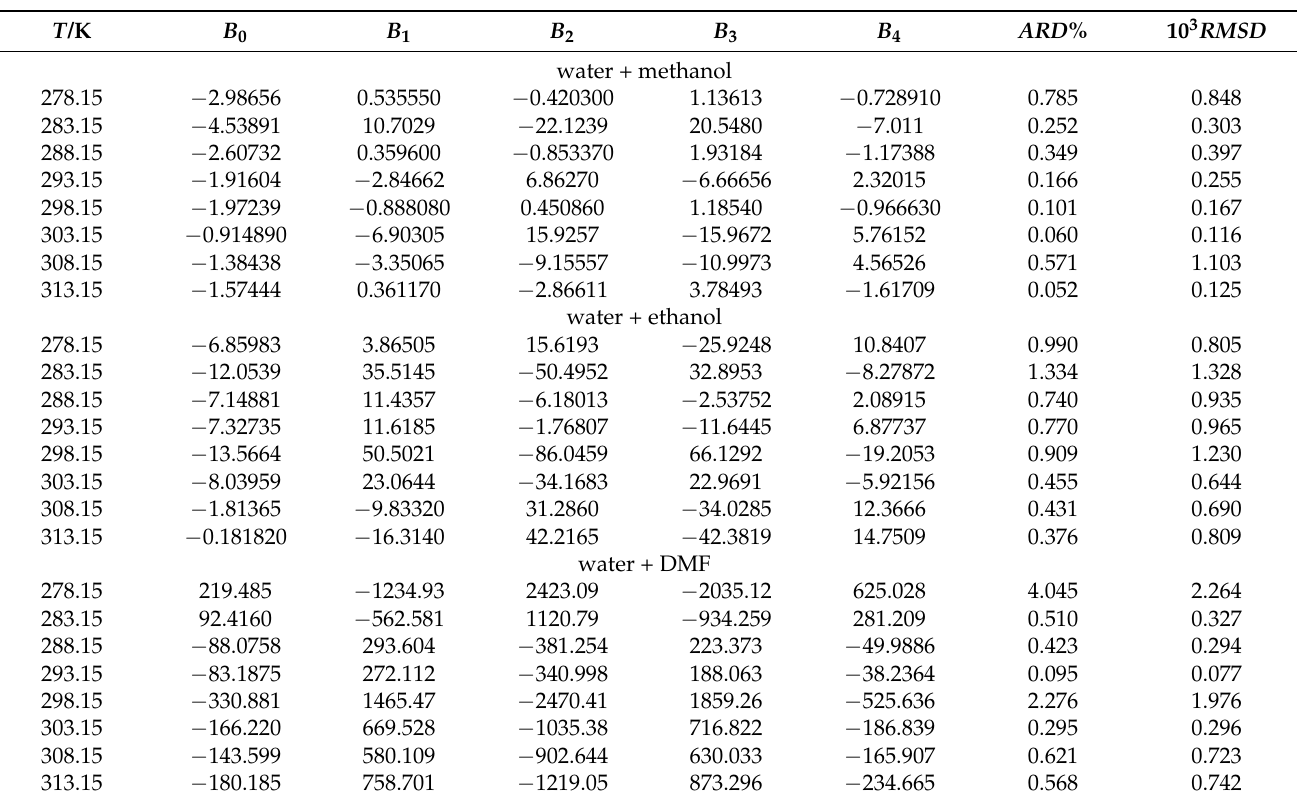
Table 8. Model parameters of CNIBS/R-K model for 1,5-pentanediamine adipate dihydrate in the investigated binary solvent mixtures a,b,c